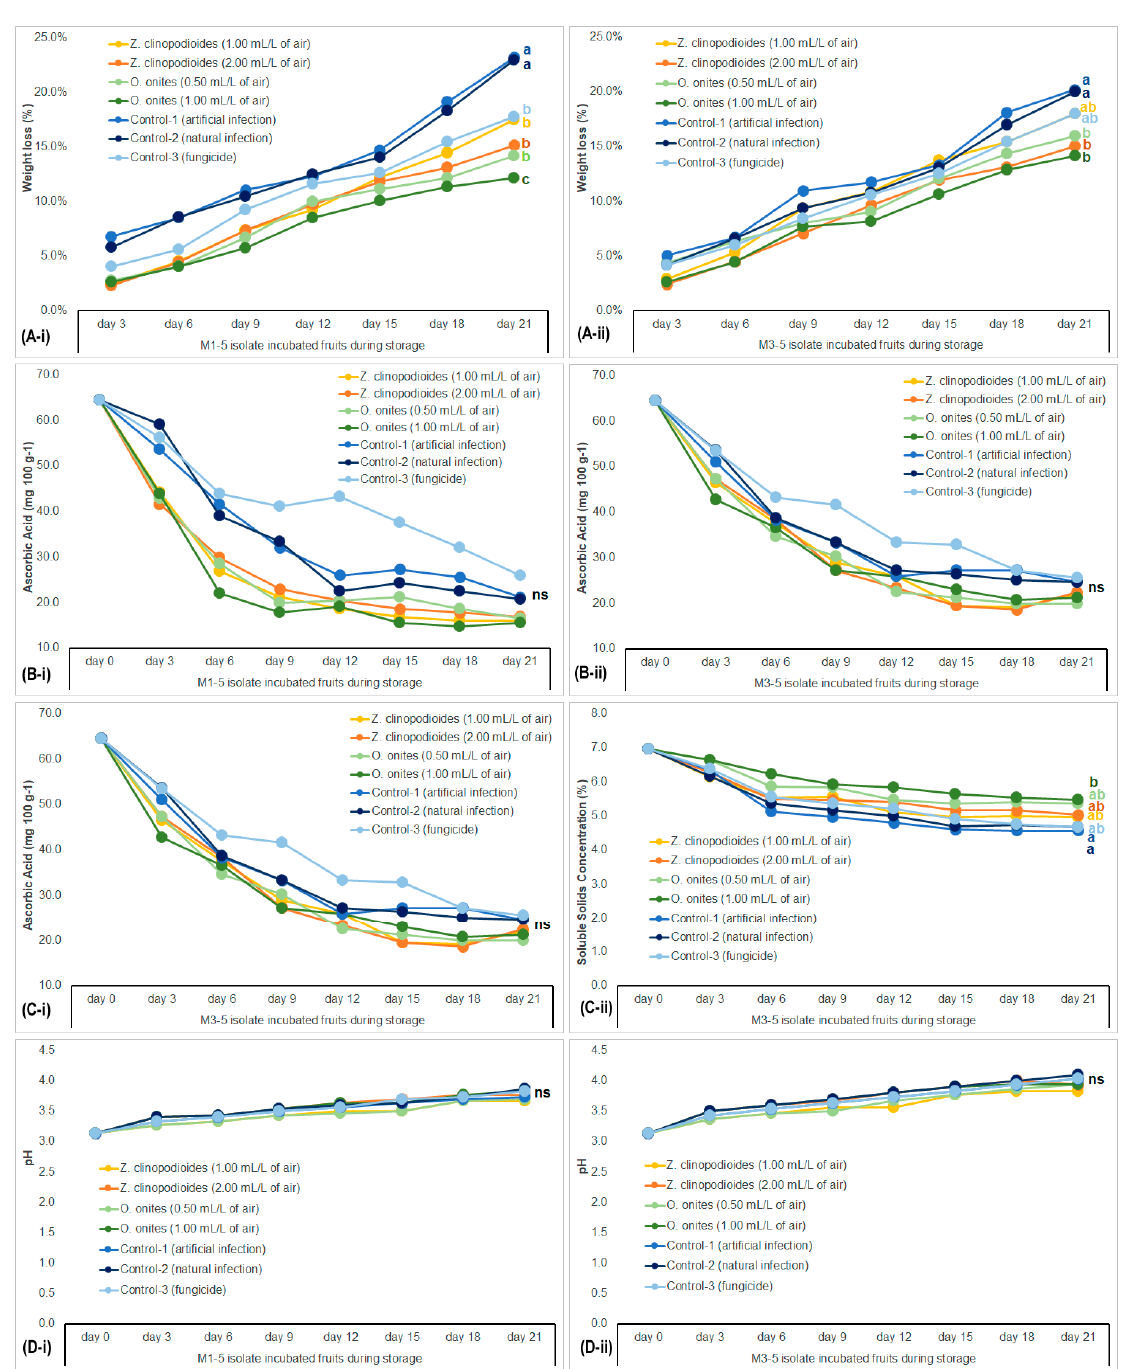
Figure 4. Vapor contact impacts of O. onites and Z. clinopodioides essential oils on the ( A ) weight loss, ( B ) ascorbic acid, ( C ) soluble solids concentration and ( D ) pH of strawberry fruits inoculated with (i) M1-5 and (ii) M3-5 isolates of B. cinerea during 21 days of storage. Different letters next to the lines of each treatment represents significant difference and ns means non-significant at the 21st day of storage, according to Tukey’s HSD test ( p ≤